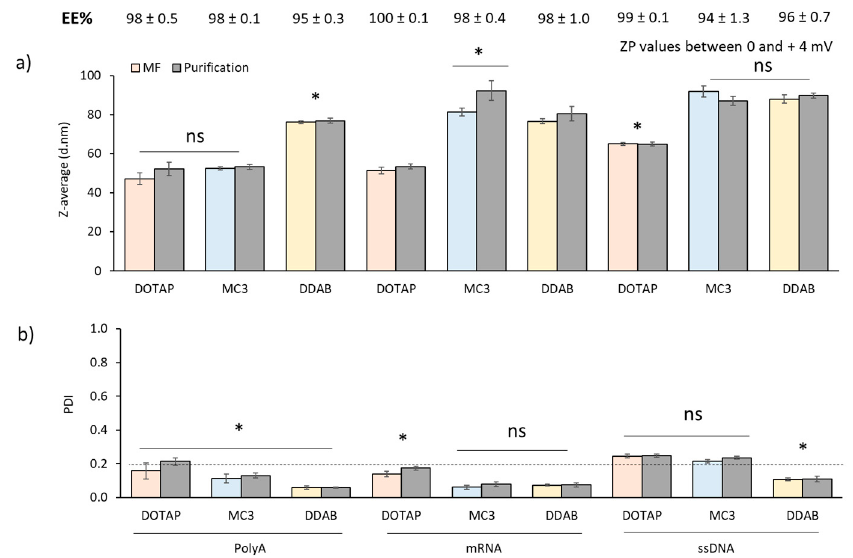
Figure 8. Loading of PolyA, ssDNA and mRNA on iLNPs (MC3) and cLNPs (DOTAP and DDAB) using citrate buffer (pH 6, 100 mM) at N/P 8 3:1 FRR and 20 mL/min TFR. ( a ) Particle size and ( b ) PDI of the DSPC:Chol:DOTAP:DMG-PEG2000 (pink), DSPC:Chol:MC3:DMG-PEG2000 (blue) and DSPC:Chol:DDAB:DMG-PEG2000 (yellow) before and after purification. Encapsulation efficiencies (EE%) for each formulation are shown as the percentage of the initial amount added (values). All formulations were prepared at 10:48:40:2 DSPC:Chol:cationic/ionisable:PEG lipid molar ratios. Results represent the mean of at least 3 independent batches and the standard deviation is plotted as error bars. Significant differences are shown as * p < 0.05, and ‘ns’, when no statistical significance observed. Figure 9. Cryo-TEM images of blank and mRNA-loaded DDAB-cLNPs (40,000× magnification, 200 kV) and GenVoy-ILM™ iLNPs (96,000× magnification, 300 kV).